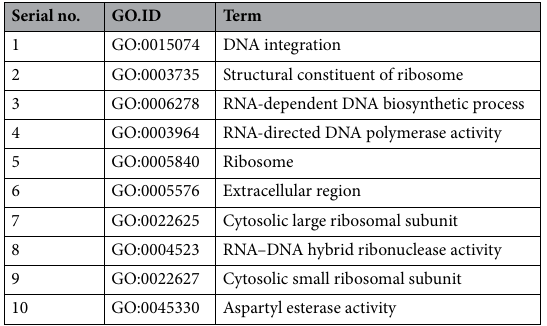
Table 5. Top 10 significant enrichment of GO function